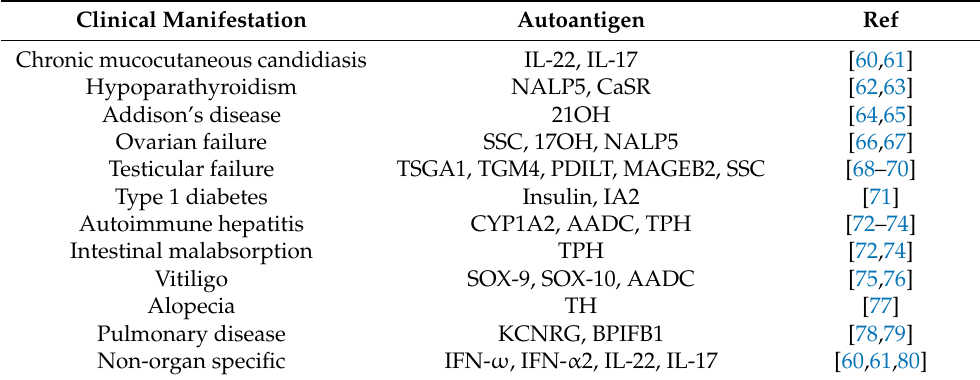
Table 1. Overview of the most important autoantigens and associated clinical manifestations in